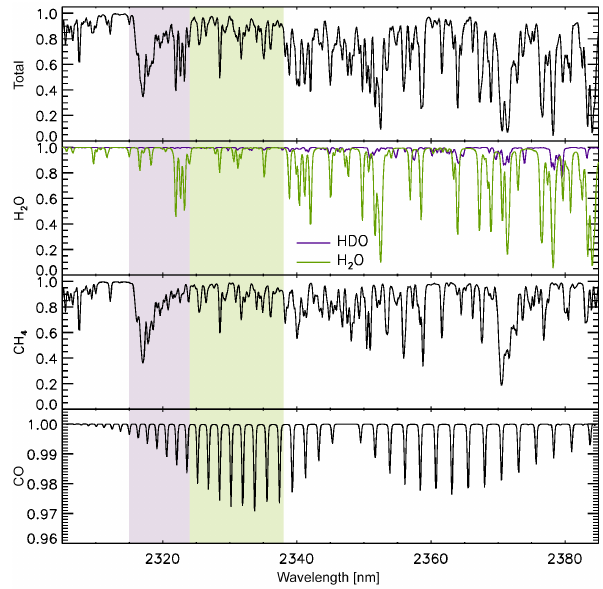
Figure 1. SWIR spectral transmittance along the light path of the solar beam reflected at the Earth surface into the instrument’s view- ing direction. Simulations are performed for viewing zenith angle VZA = 0 ◦ , and a solar zenith angle SZA = 30 ◦ , and by assuming a US standard atmospheric profile. From top to bottom, the figure shows the total transmittance, the individual transmittances due to H 2 O (green line), HDO (purple line), CH 4 and CO, respectively. The purple region indicates the spectral range 2315–2324nm that is used for cloud filtering, whereas the green area highlights the adja- cent spectral range 2324–2338nm, which is used to infer CO total columns from the measurements. Note the different y axis scale for the CO